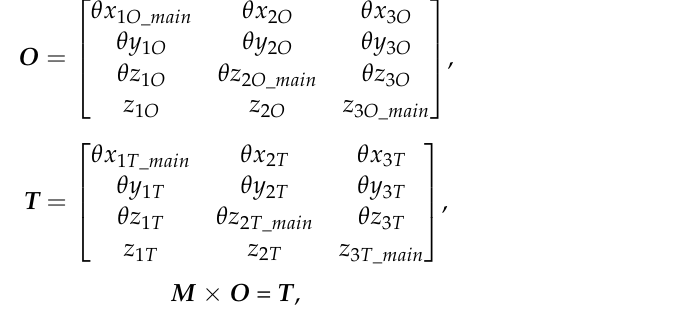
Figure 4. ( a ) The test bench; ( b ) movement element. The value measured by the laser interferometer and autocollimator is called the true value, as described below and shown in the following figure as θ x _True, θ z _True, and z _True. Owing to the limitation of the autocollimator, the true value of θ y was obtained during another set of repeated experiments by changing the measurement surface. The following single motion, resolution, and multiple motion experiments were carried out in this study. The pre-experiment was performed in θ x (80 ′′ ), θ z (80 ′′ ), and the z-direction (100 μ m) as the main motions and obtained all the constant parameters and the error compensation matrix ( M ) in Formulas (2)–(8). As is evident from Figure 2b, it is difficult to adjust the